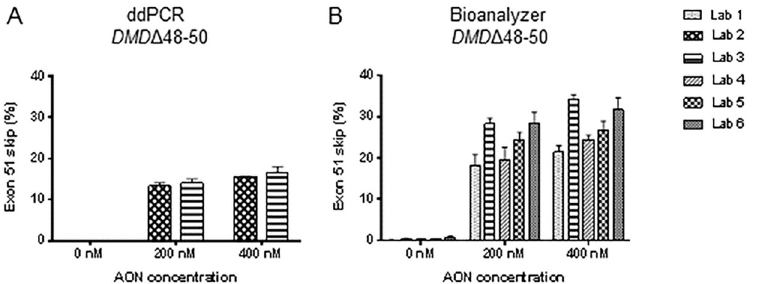
Fig 3. Bar graphs showing exon skipping levels of DMD Δ 48–50(A-B) cells after transfection with AON h51AON2 to skip exon 51 (2 nd transfection experiment). Two different protocols were tested. Error bars represent standard deviation.